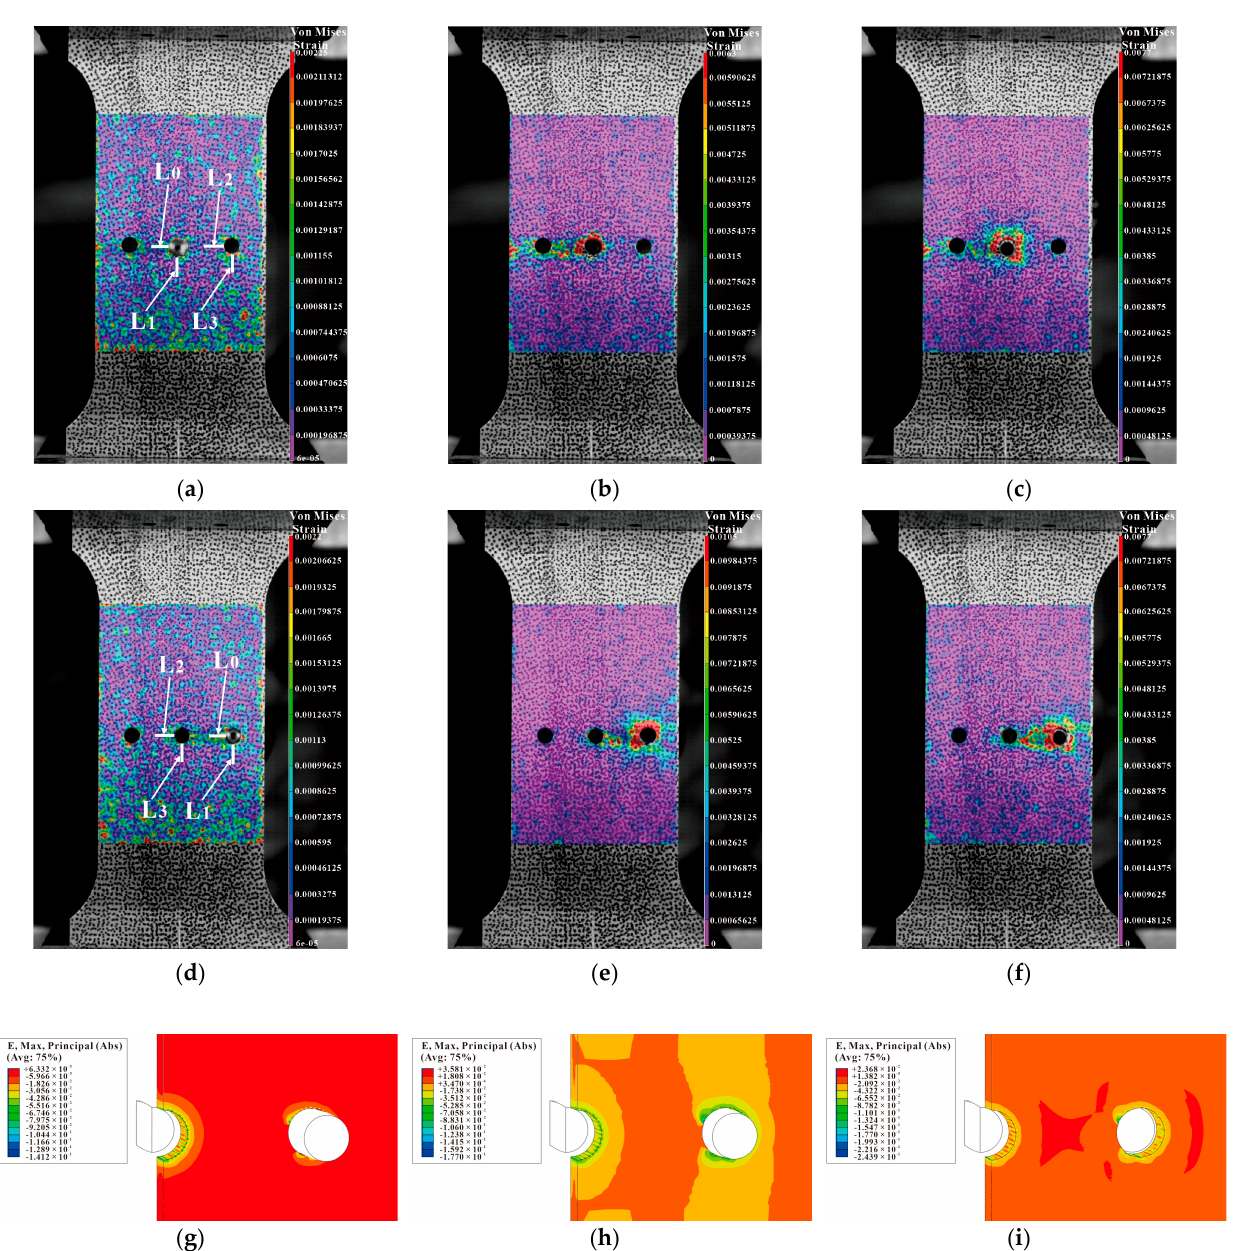
Figure 25. Comparison between DIC strain detection and FEM-predicted strain of three-hole speci- men with three times the hole diameter as hole spacing (sequential extrusion): ( a – c ) strain distribu- tions before, during, and after SSCE of the middle hole; ( d – f ) strain distributions before, during, and after SSCE of the right hole; ( g – i ) the right-hole SSCE strain distribution of FEM.